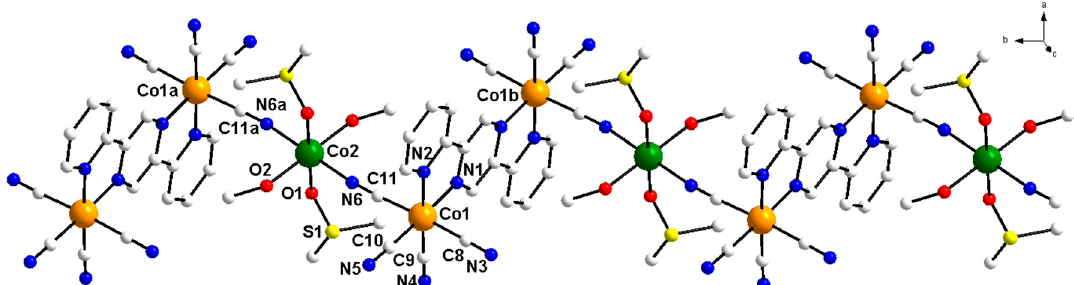
Figure 1. View of a part of the neutral chain of 1 along with the atom numbering of the chromophores. Free methanol molecules were not represented for the sake of clarity [symmetry code: (a) = 1 − x , − 1 − y , 3 − z ; (b) = x , − 1 + y , z ]. The same atom numbering was used for 2 .